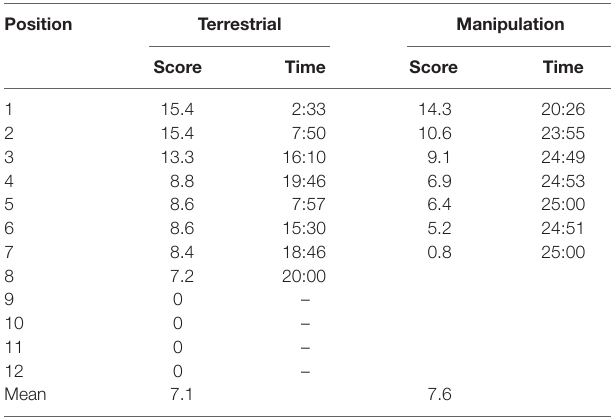
tABLe 4 | Results of the terrestrial race and manipulation scenario. Position terrestrial Manipulation